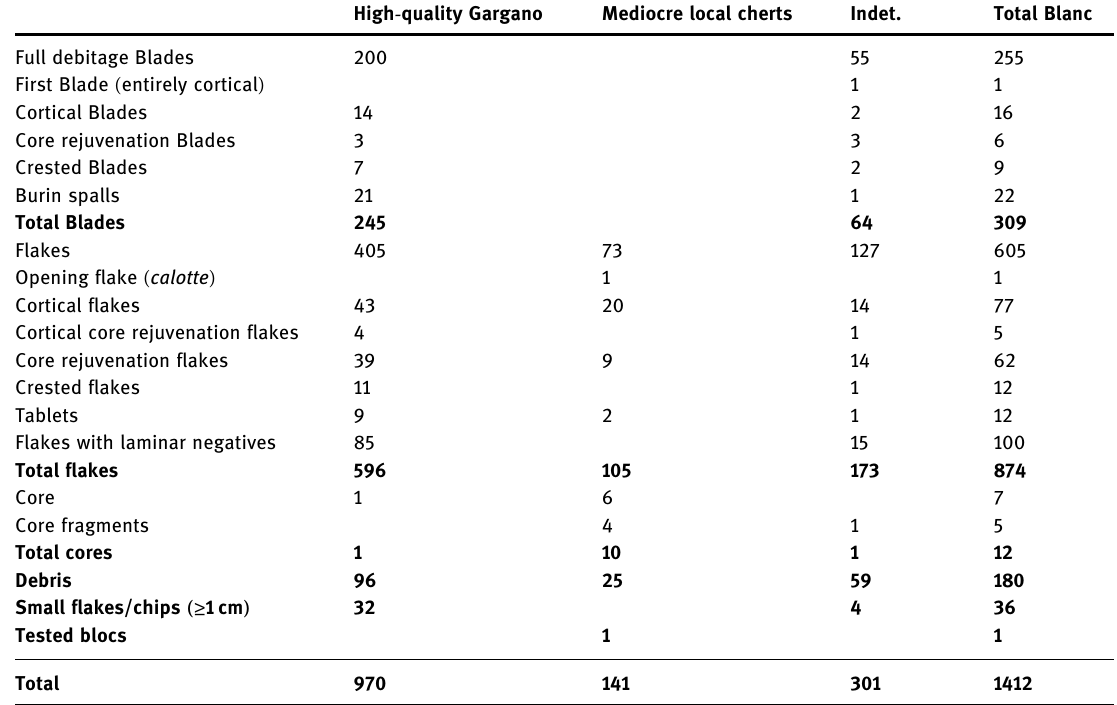
Table 1: Crno Vrilo Sector A: Lithic assemblage breakdown by main raw material groups and technological categories High - quality